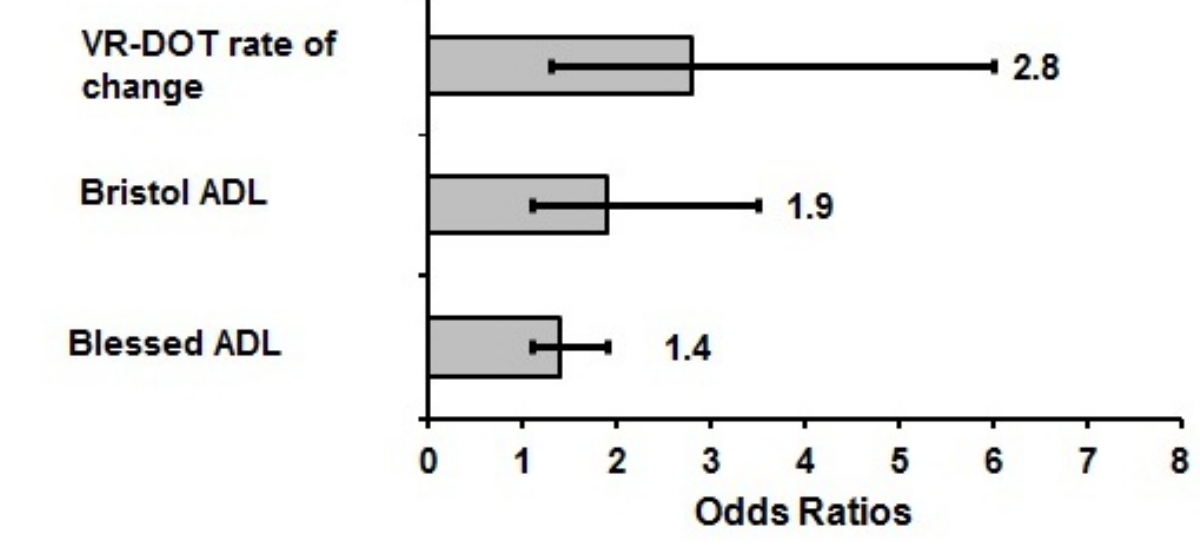
Figure 4. Odds ratios from exploratory individual regression analyses using VR-DOT, Bristol, and Blessed ADL scale scores rate of change as predictors for conversion from mild cognitive impairment to Alzheimer disease (bars represent 95%